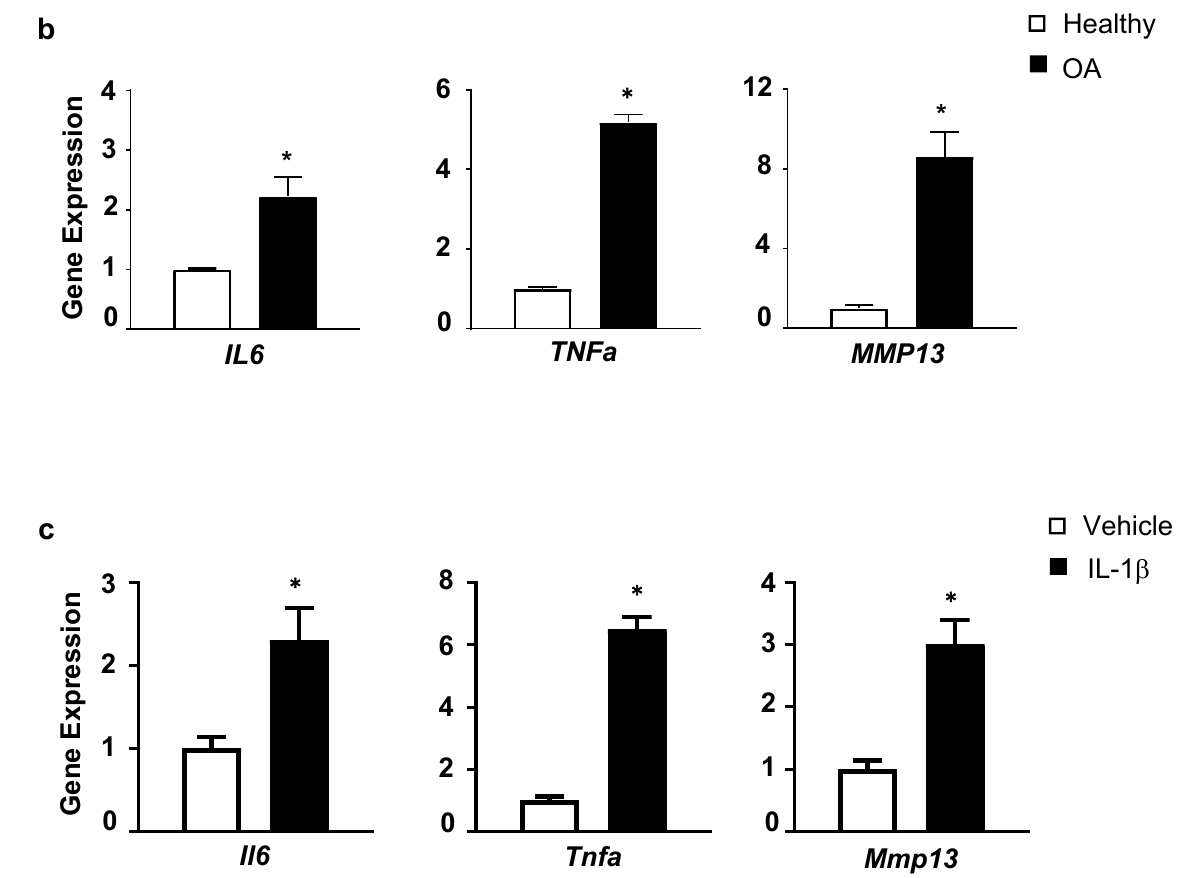
Figure 1. Inflammation occurs in OA cartilage, and IL-1 β induces inflammatory responses and catabolic markers in articular chondrocytes. ( a ) Immunohistochemistry (IHC) for phospho-p65 on articular cartilage sections from healthy and OA patients (n = 3) (scale bar, 100 µ m); ( b ) Real-time qPCR analyses of gene expression for IL6 , TNF α , and MMP13 in articular chondrocytes from healthy or OA patients (n = 3); ( c ) Relative gene expression for Il6 , Tnf α , and Mmp13 in primary murine articular chondrocytes treated with IL-1 β or vehicle (n = 3). Data presented as mean ± SD. * p < 0.05 by Student’s t